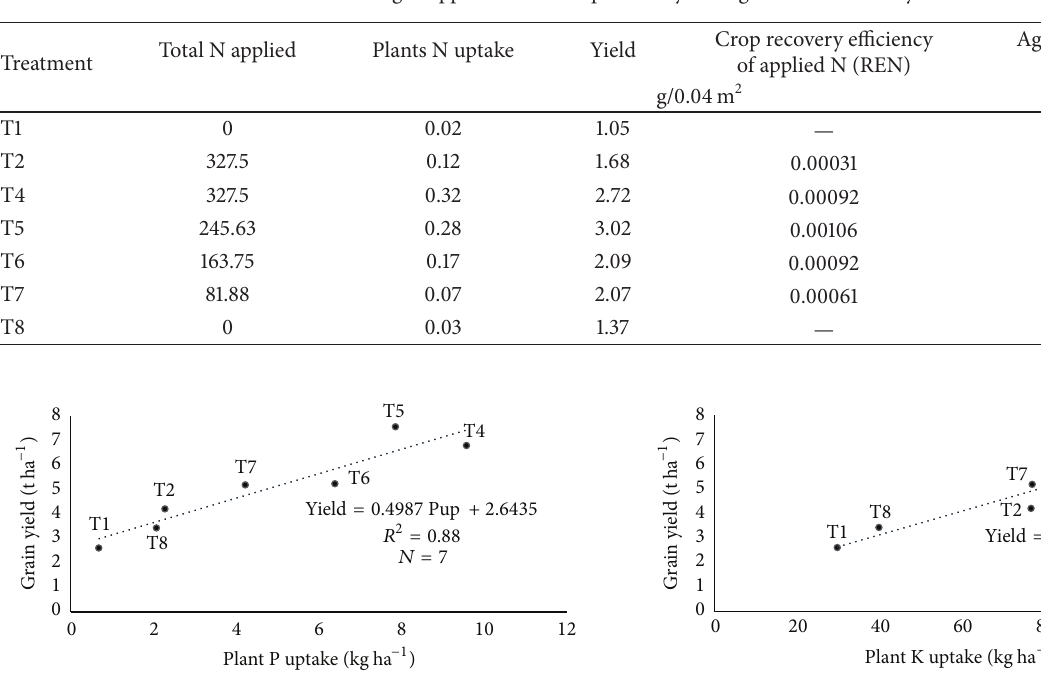
Figure 3: Relationship between P uptake and grain yield under different treatments, where Pup = phosphorus uptake.